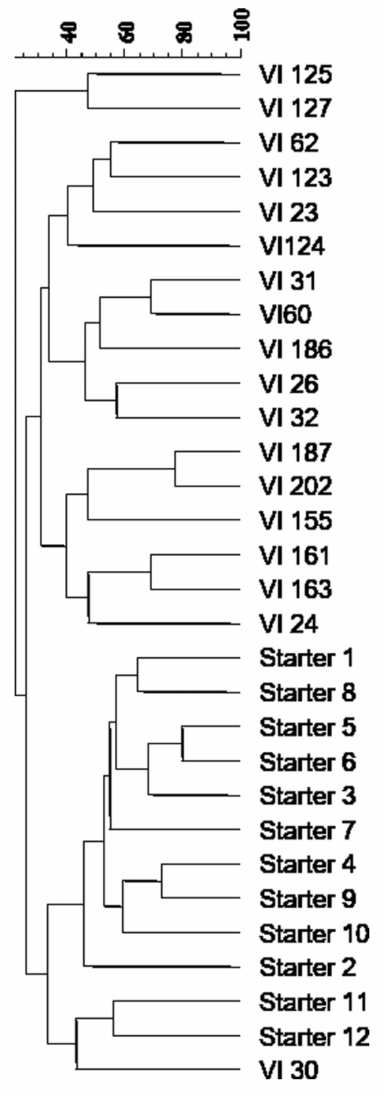
Figure 2. Dendrogram from UPGMA clustering analysis, based on the Dice coefficient of the inter- δ patterns of the indigenous S. cerevisiae strains isolated from the spontaneous fermentations and the commercial starter strains usually used in the winery. Table 1. Oenological and technological features of the 18 indigenous S. cerevisiae strains evaluated through 160 mL-fermentations with sterile grape must at 25 ◦ C (+: presence; -: absence, underlined: S . cerevisiae strains selected for a further